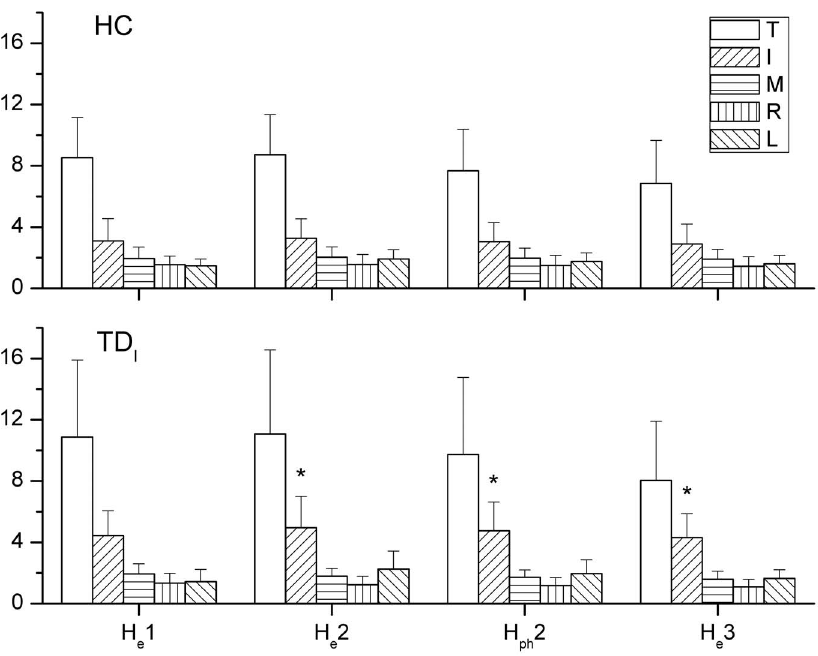
Figure 3. The significant difference of applied RF between TD I and HC during holding. The RF of each digit at all events and the averaged RF during second phase of the holding task by HC ( upper ) and TD I ( lower ). Larger forces of the index finger were found at H e 2 and H e 3 and during second phase for TD I when compared to those for HC. Significant differences are indicated by * ( p , 0.05).